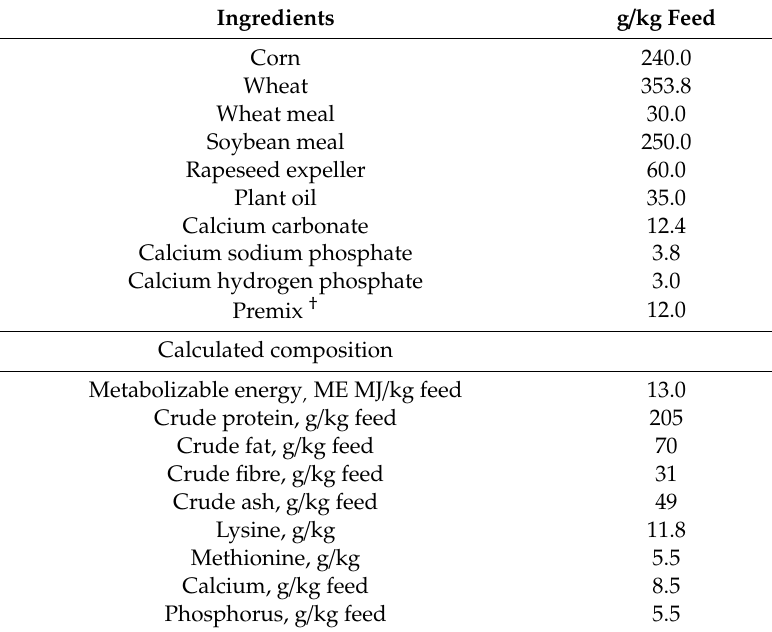
Table 1. Ingredients of the basal